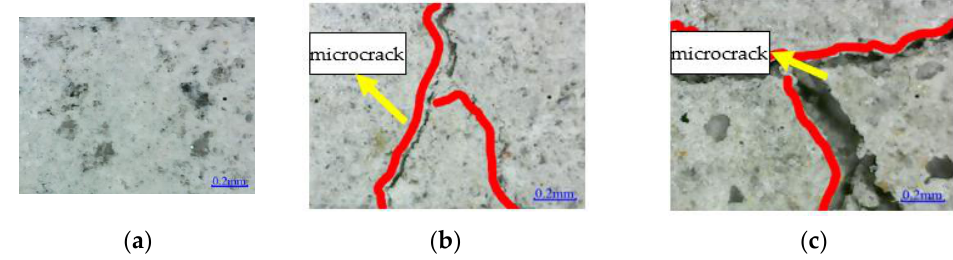
Figure 18. Microstructure of concrete surface: ( a ) URFND; ( b ) URFSI-400; and ( c ) URFSF-100.